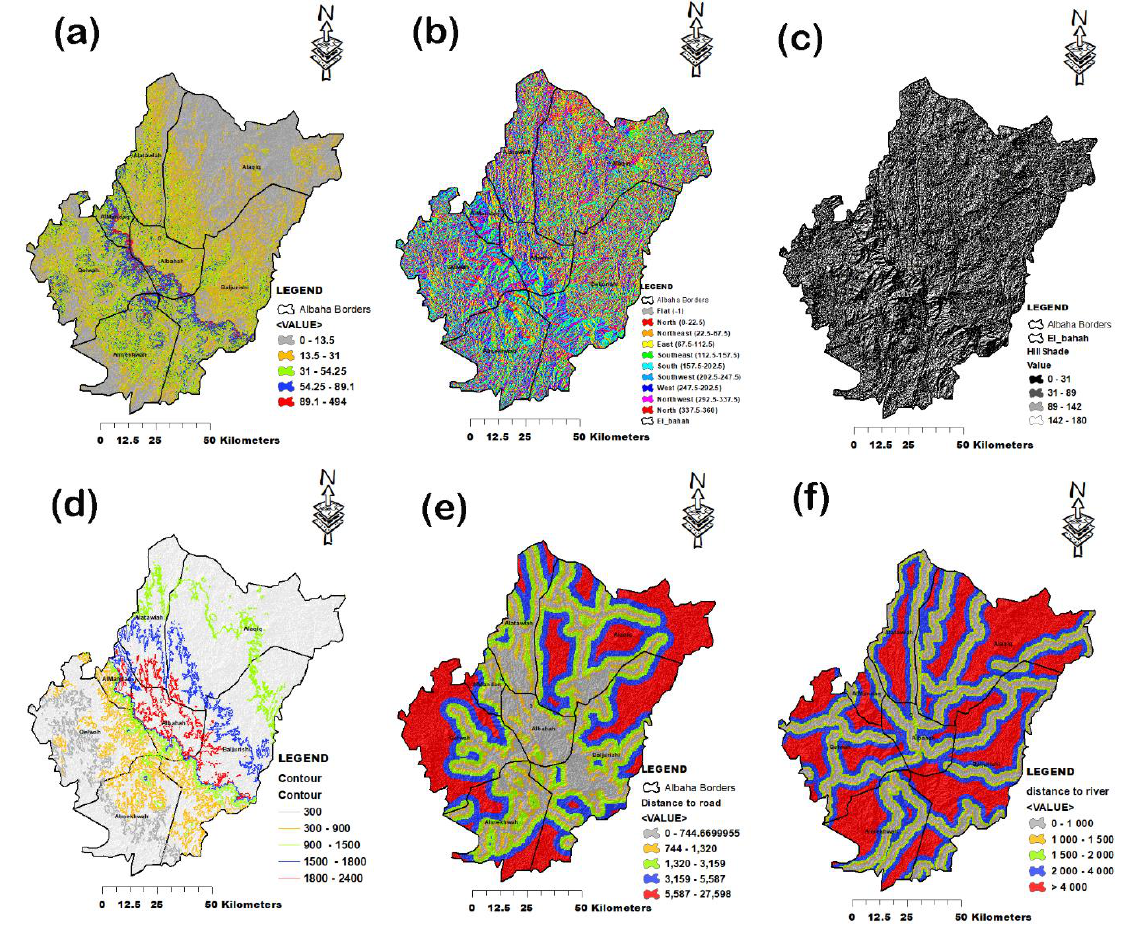
Figure 2. Representation of maps showing ( a ) slope, ( b ) aspect, ( c ) hill shades, ( d ) contours, ( e ) distance from the road and ( f ) distance from the river.